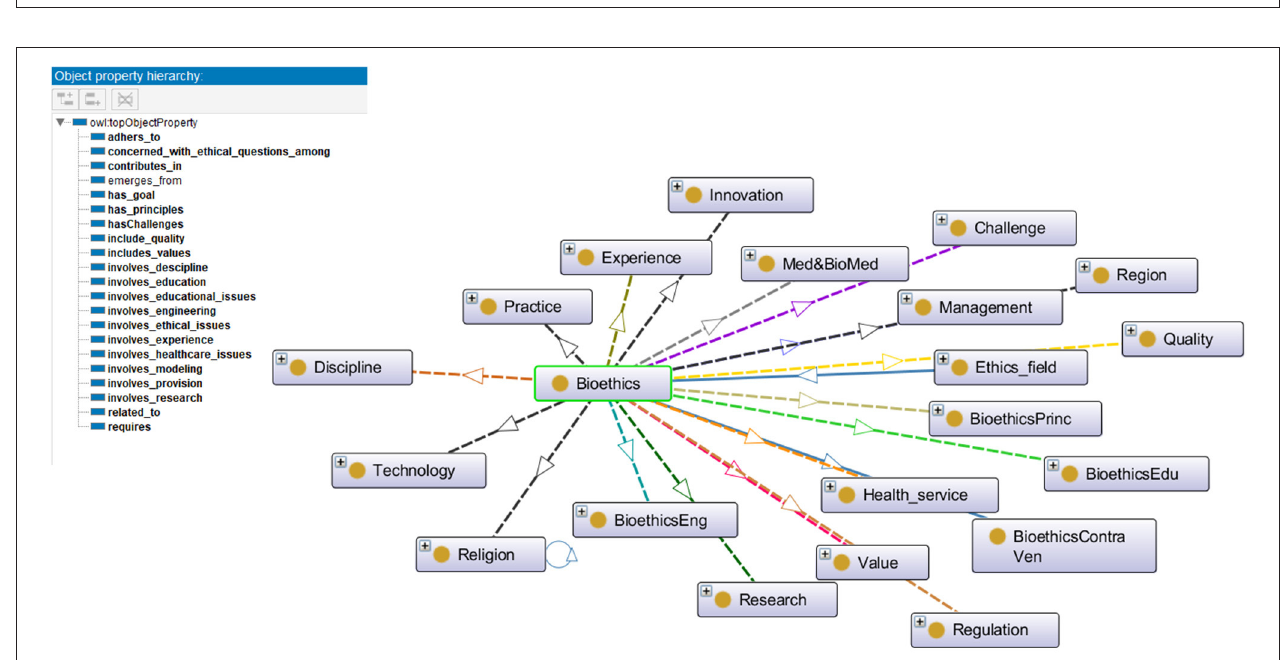
FIGURE 2 | The top-level bioethics classes and the class hierarchy.